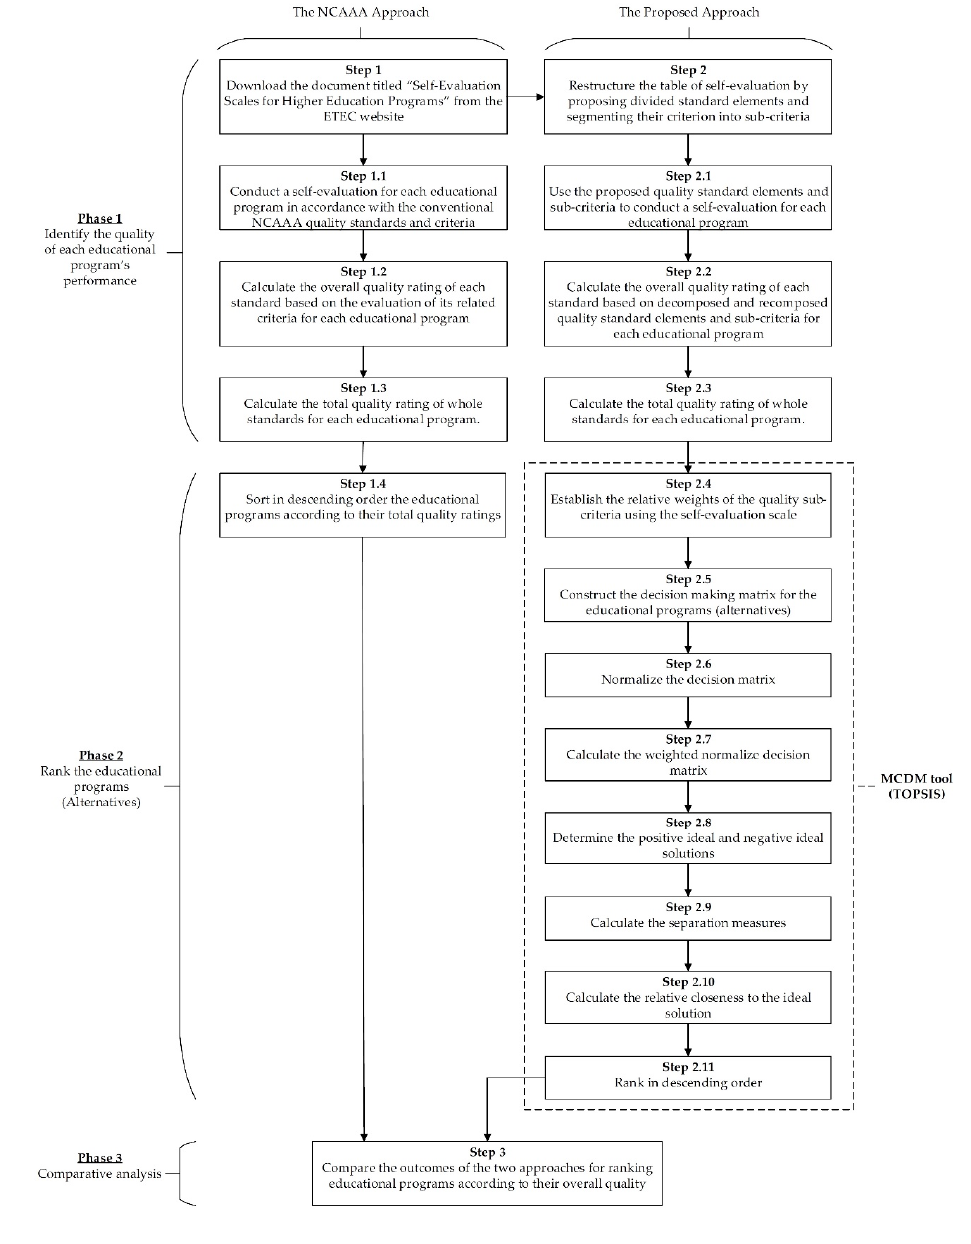
Fig. 1. The framework for comparing the NCAAA approach with the proposed